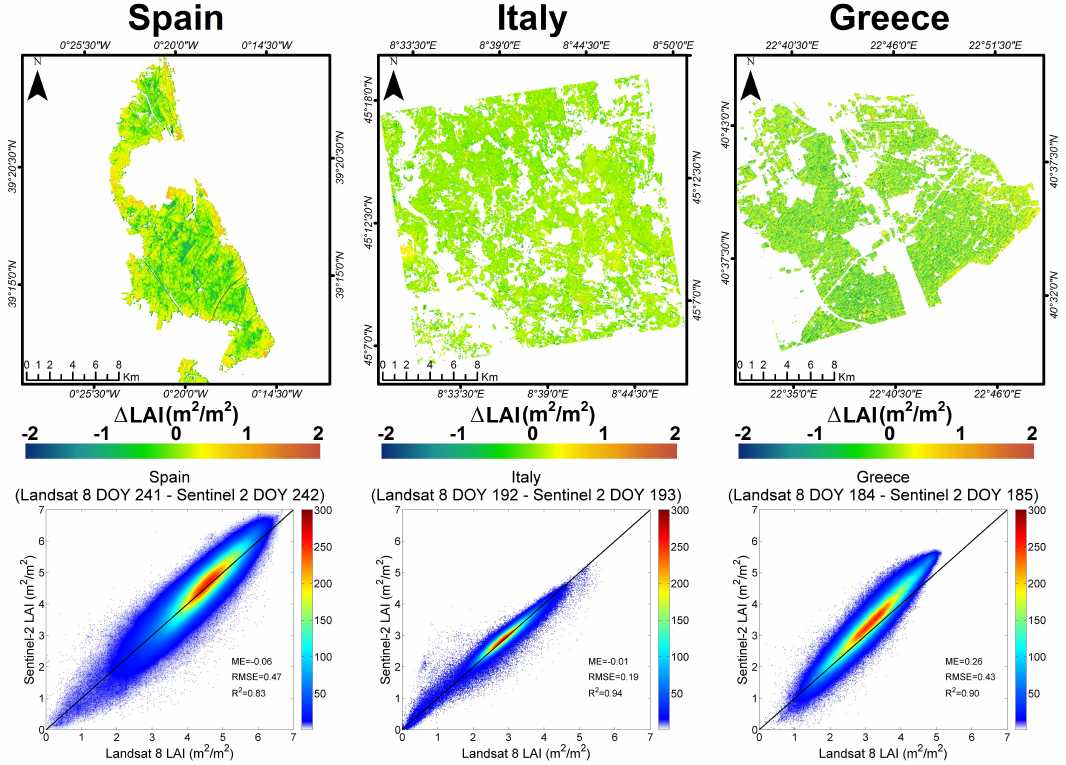
Figure 5. LAI difference maps (Top) and the corresponding scatter plots of the closest Sentinel-2A and Landsat-8 LAI estimates (Bottom) over Spain (Left), Italy (Middle) and Greece